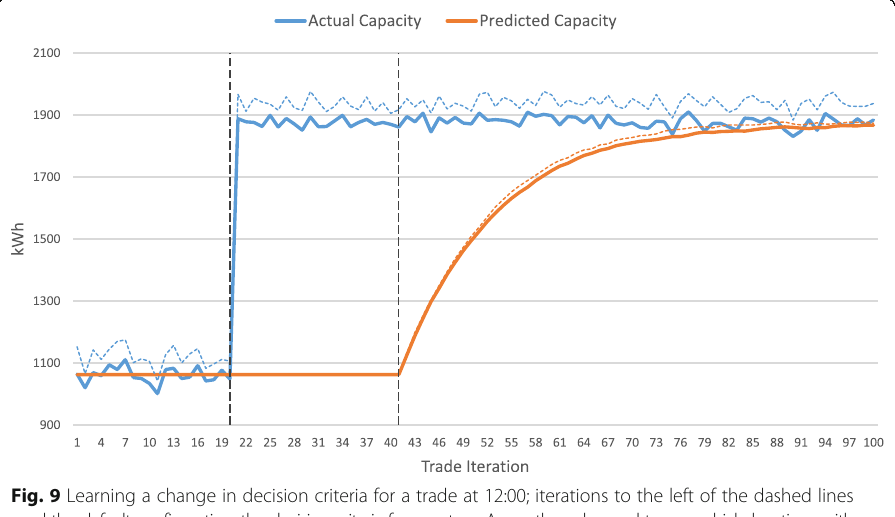
Fig. 9 Learning a change in decision criteria for a trade at 12:00; iterations to the left of the dashed lines used the default configuration, the decision criteria for user type A was then changed to use vehicle locations with no learning enabled, which was enabled for iterations to the right of the dashed lines. Results are averaged over 10 simulations. Dotted lines show +1 standard